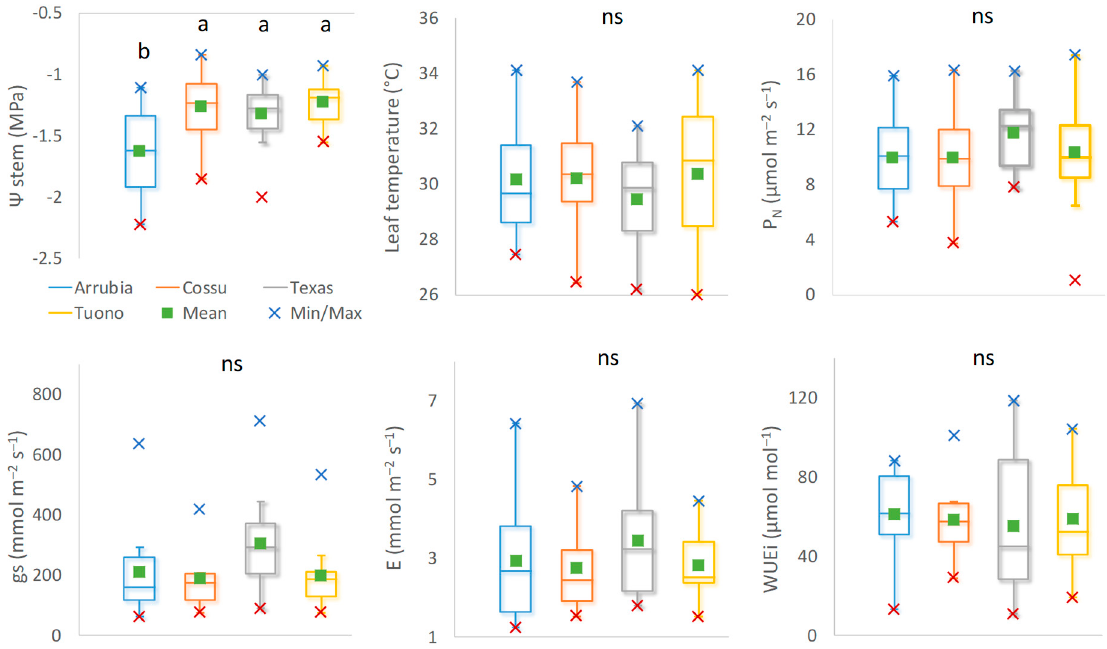
Figure 4. Boxplot and one-way ANOVA significance of differences among varieties of observed midday stem water potential, leaf temperature, net photosynthesis, stomatal conductance, transpiration, and intrinsic water use efficiency rates during nut growing stage. Data are the mean of tree replicates from the 11 dates of measurements (n = 55). Box limits are the first and third quartile. Different lowercase letters indicate significant differences in mean values among cultivar and ns indicates not significant differences among cultivar.